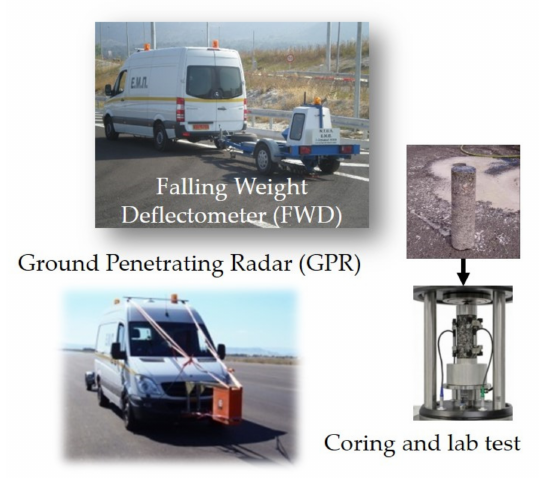
Figure 2. Experimental testing components.